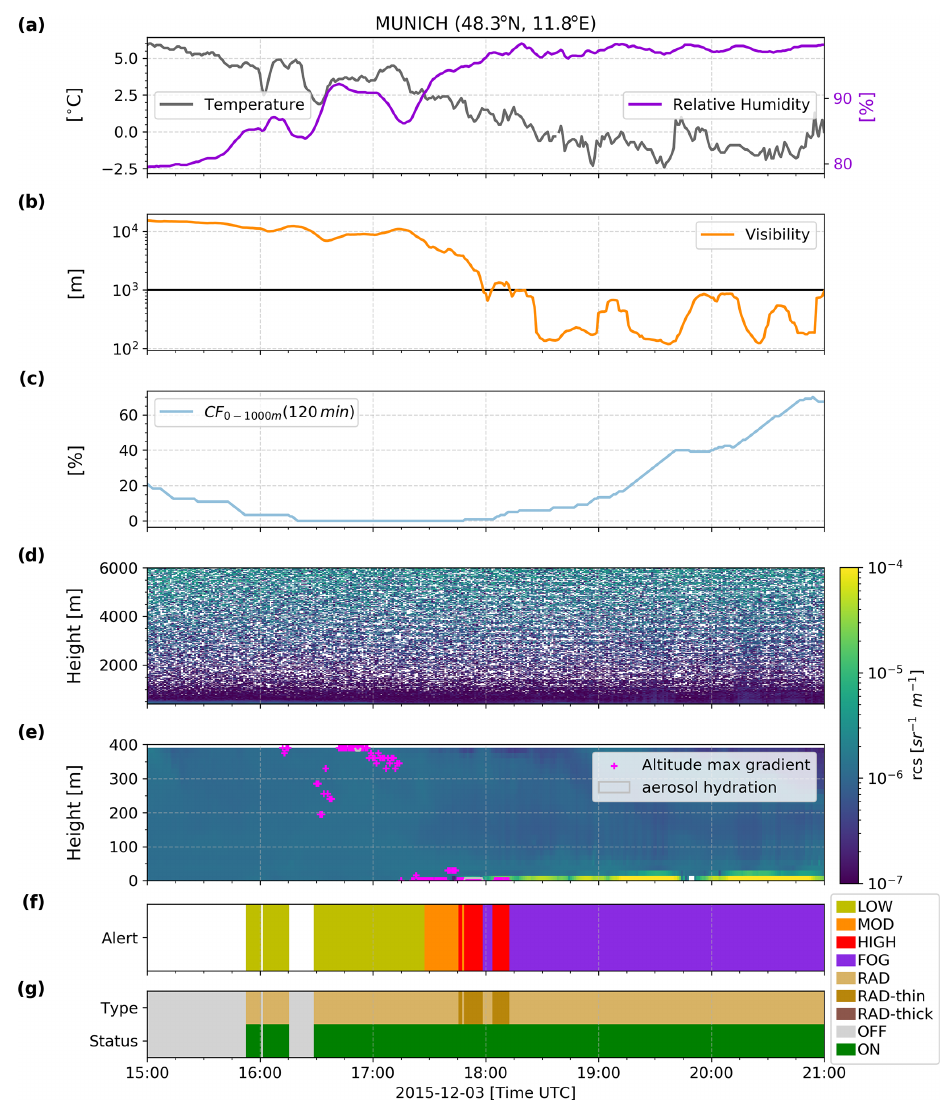
Figure 5. Time series presenting measurements and the corresponding retrieved alert level outputs from PARAFOG v2.0 during a thin radiation fog formation on 3 January 2011 at Munich airport. (a) Temperature and relative humidity, (b) visibility at 4m, (c) the cloud fraction (CF) between 0 and 1000m over the last 2h, (d) ALC-attenuated backscatter between 400 and 6000m, (e) ALC-attenuated backscatter between 0 and 400m (color contours), together with the altitude of the maximum gradient (fuchsia points) and the aerosol hydration (gray contours), (f) alert levels retrieved from PFG2, and (g) fog type and PFG2